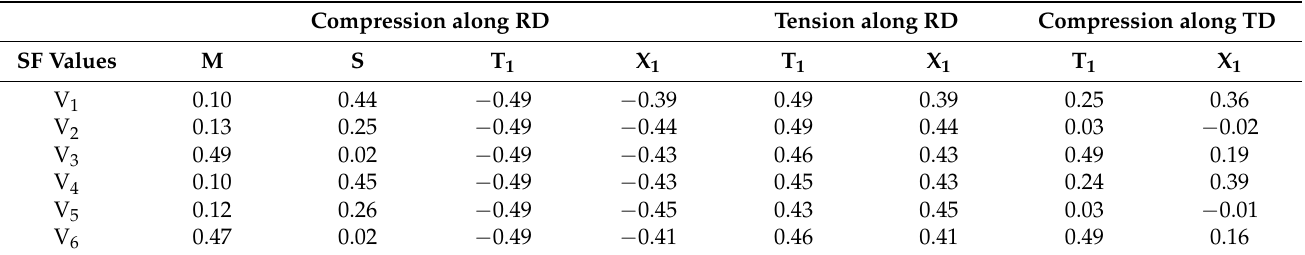
Table 1. Twin variants and their corresponding SF values in the selected grains under different loading directions.